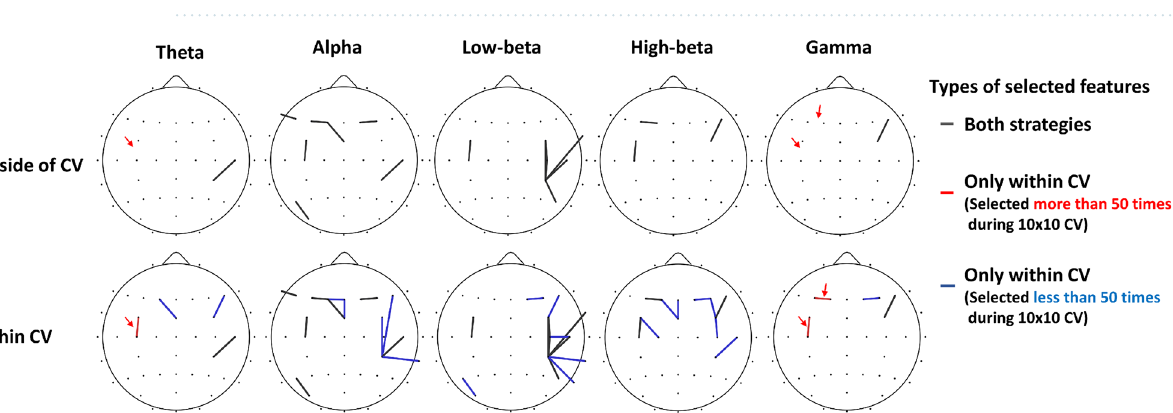
Figure 3. Prediction accuracies of two different feature selection approaches (outside of CV and within CV) for SVM and RLDA (unit: %) with respect to the number of selected features for the actual clinical EEG data. Note that features were sequentially selected with higher votes, and the corresponding features were independently used to estimate classification accuracies for each feature number. As the number of features selected by the within CV feature selection method varied in each CV loop, we averaged the prediction accuracies of a specific number of features selected in each CV loop. However, features fixed after the feature selection performed outside of CV were used to estimate classification accuracies as a function of the number of features.